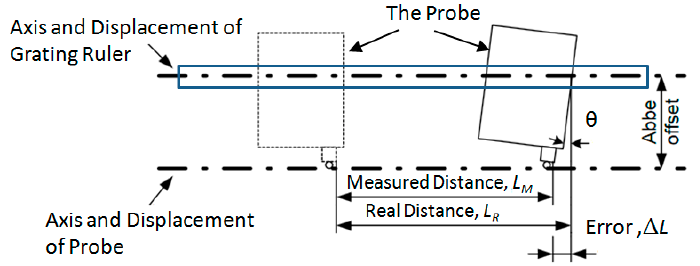
Figure 1. An illustration of an Abbé error.